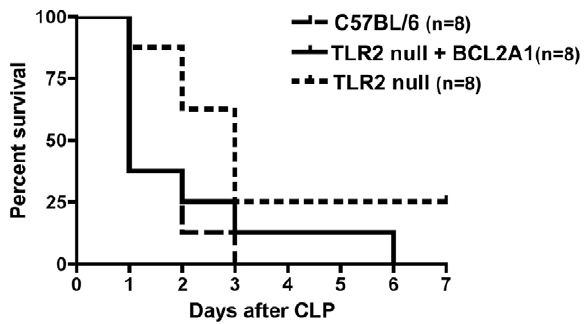
Figure 6. Treatment with rhBCL2A1 does not protect TLR2-null mice. C57BL/6 or TLR2-null mice were subjected to CLP and followed for 7 days. An assessment table was used as a surrogate marker for death, and the animals were euthanized according to approved criteria. Animals were treated by i.p. injection of saline or 1 m g rhBCL2A1 at 18 hours prior to CLP, at the time of CLP, and then every 12 hours for the 3 consecutive days. There was no significant difference in survival between the treatment